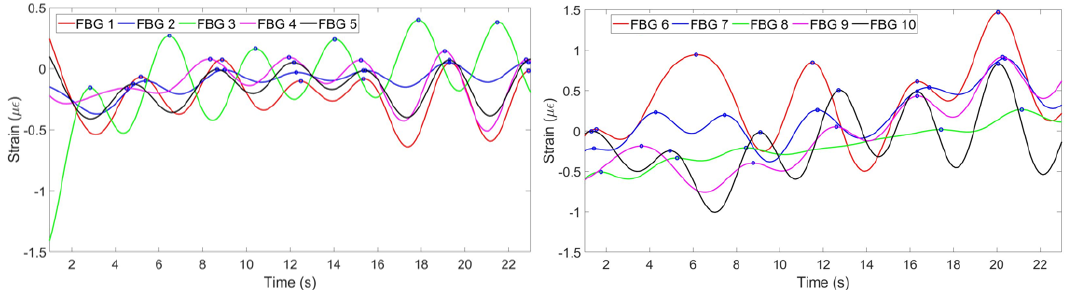
Figure 14. Breathing pattern for the first volunteer in the sitting position detected by FBGs on the chest ( left ) and abdomen regions ( right